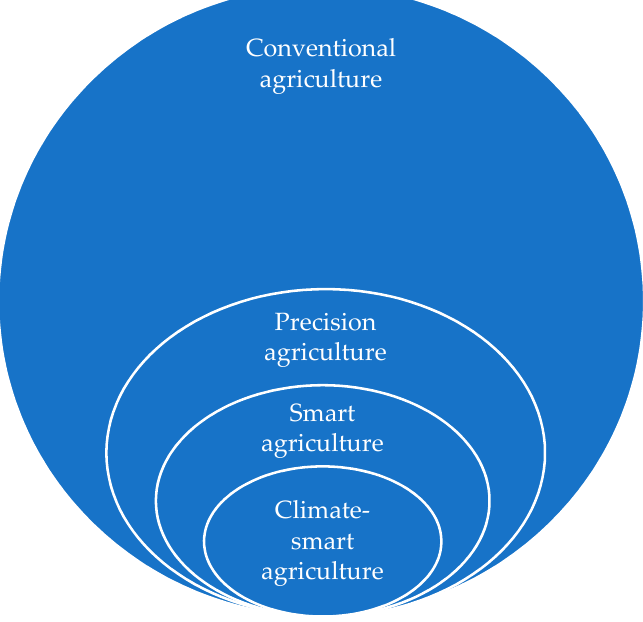
Figure 1. The simplified relationship of the different agricultural systems.